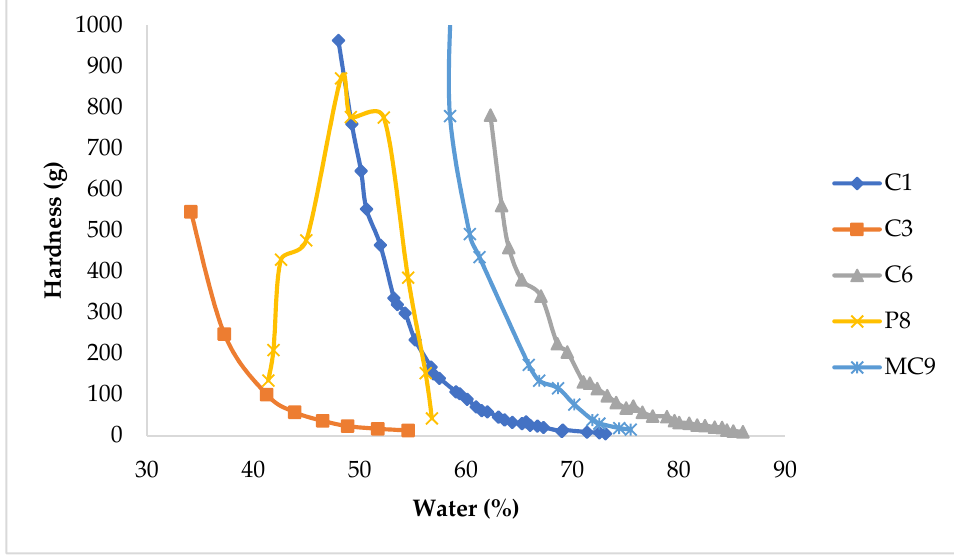
Figure 2. Plots of hardness of the pastes against % water content.